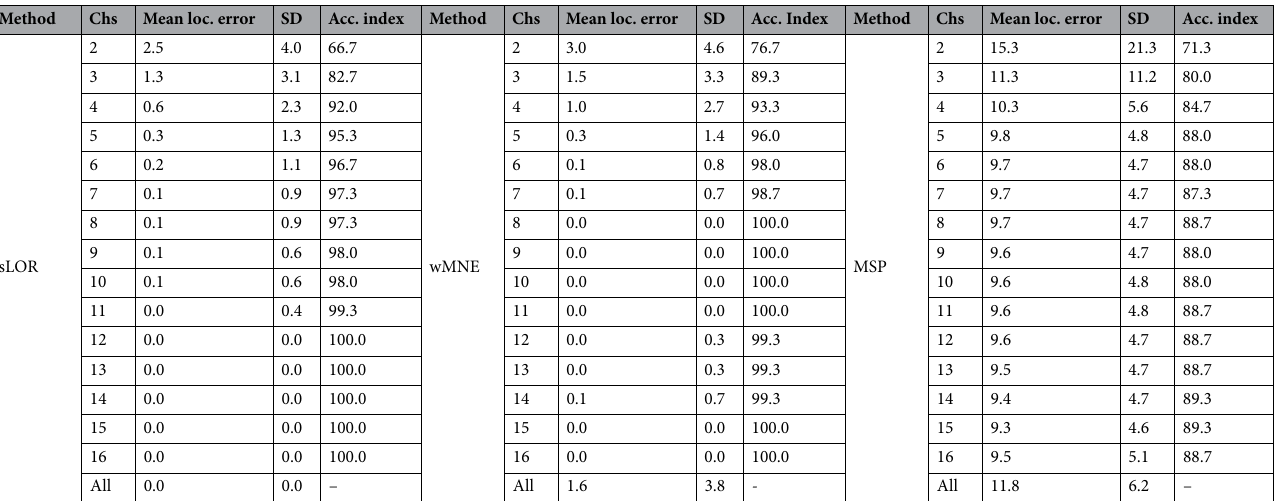
Table 1. Summary of the localization error obtained with the optimized combinations of channels, from 2 to 16, and with the full set of 231 electrodes. The accuracy index represents the percentage of trials with the given number of channels that obtained equal or lower localization error than when using all the electrodes for the same